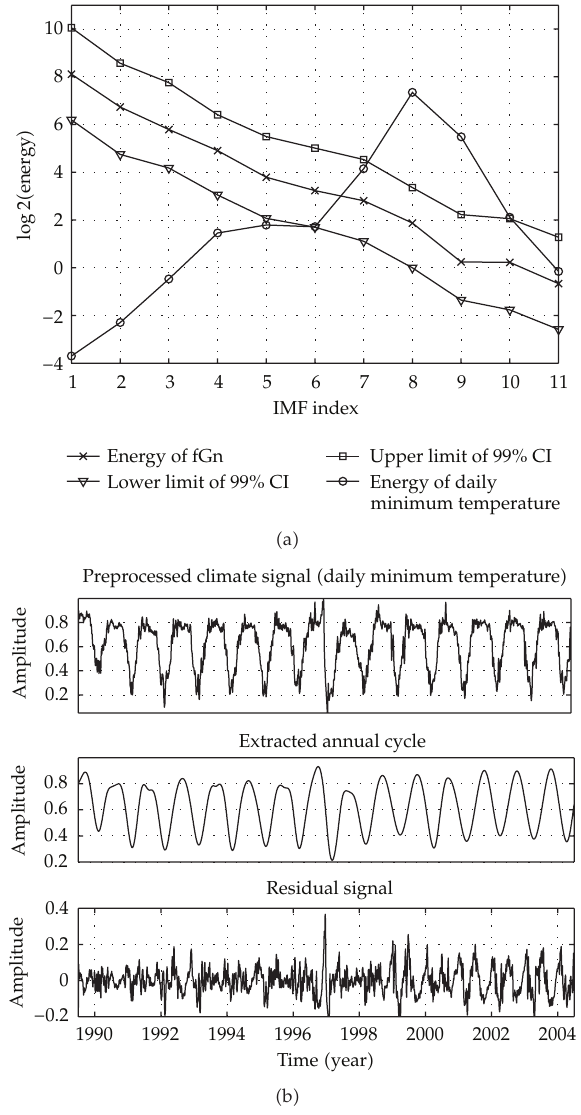
Figure 10: (cid:2) a (cid:3) The energy distribution of fGn over the IMFs, its upper and lower bounds with 99% confidence interval. The energies of individual IMF of daily minimum temperature signal indicate that the 8th one is the starting IMF to represent the annual cycle. (cid:2) b (cid:3) The separation of annual cycle of daily maximum temperature. The preprocessed climate signal (cid:2) top (cid:3) , extracted annual cycle (cid:2) middle (cid:3) , and the residual signal (cid:2) bottom (cid:3)